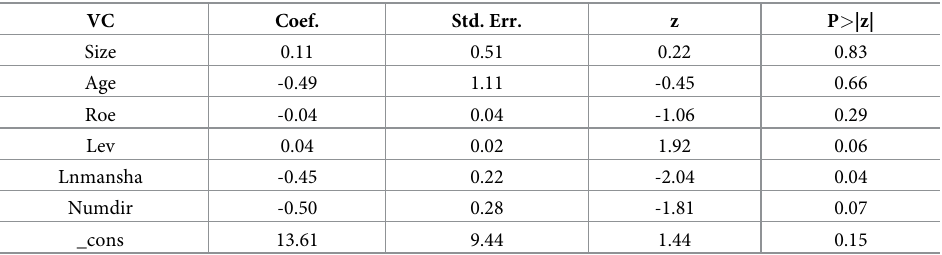
Table 4. Regression of risk capital selection influencing factors.